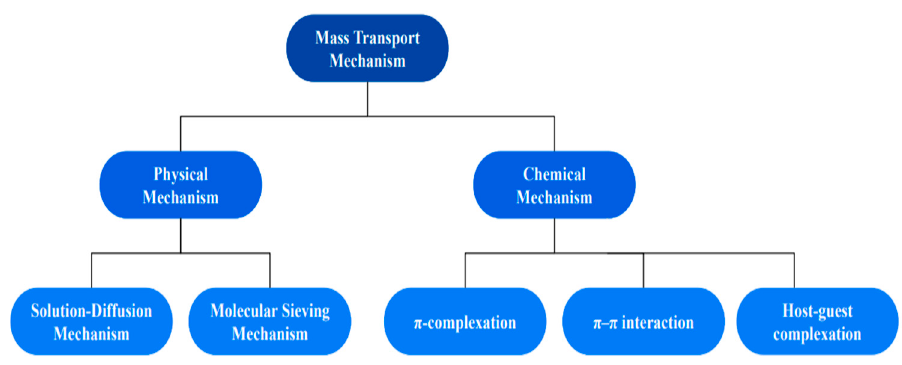
Figure 1. Classification of mechanisms of mass